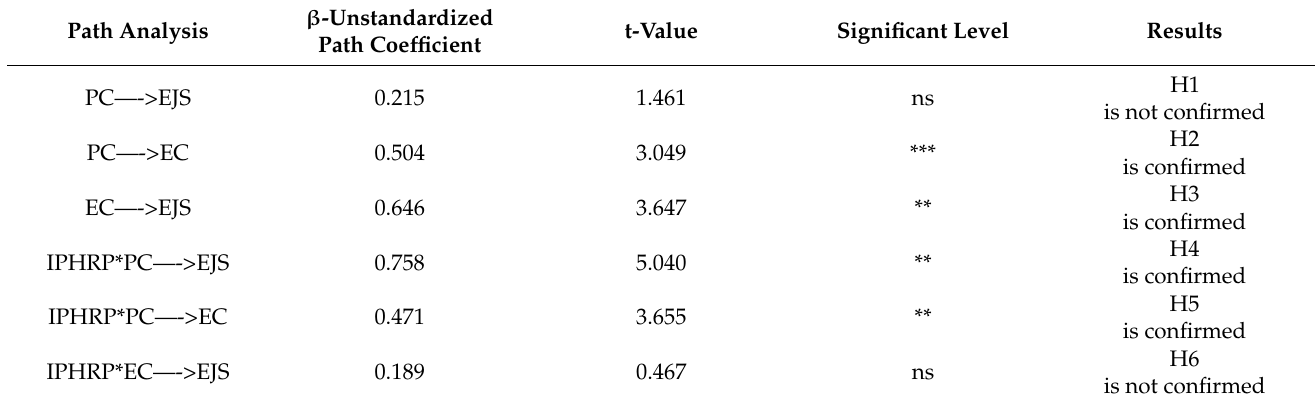
Table 4. Hypotheses tests